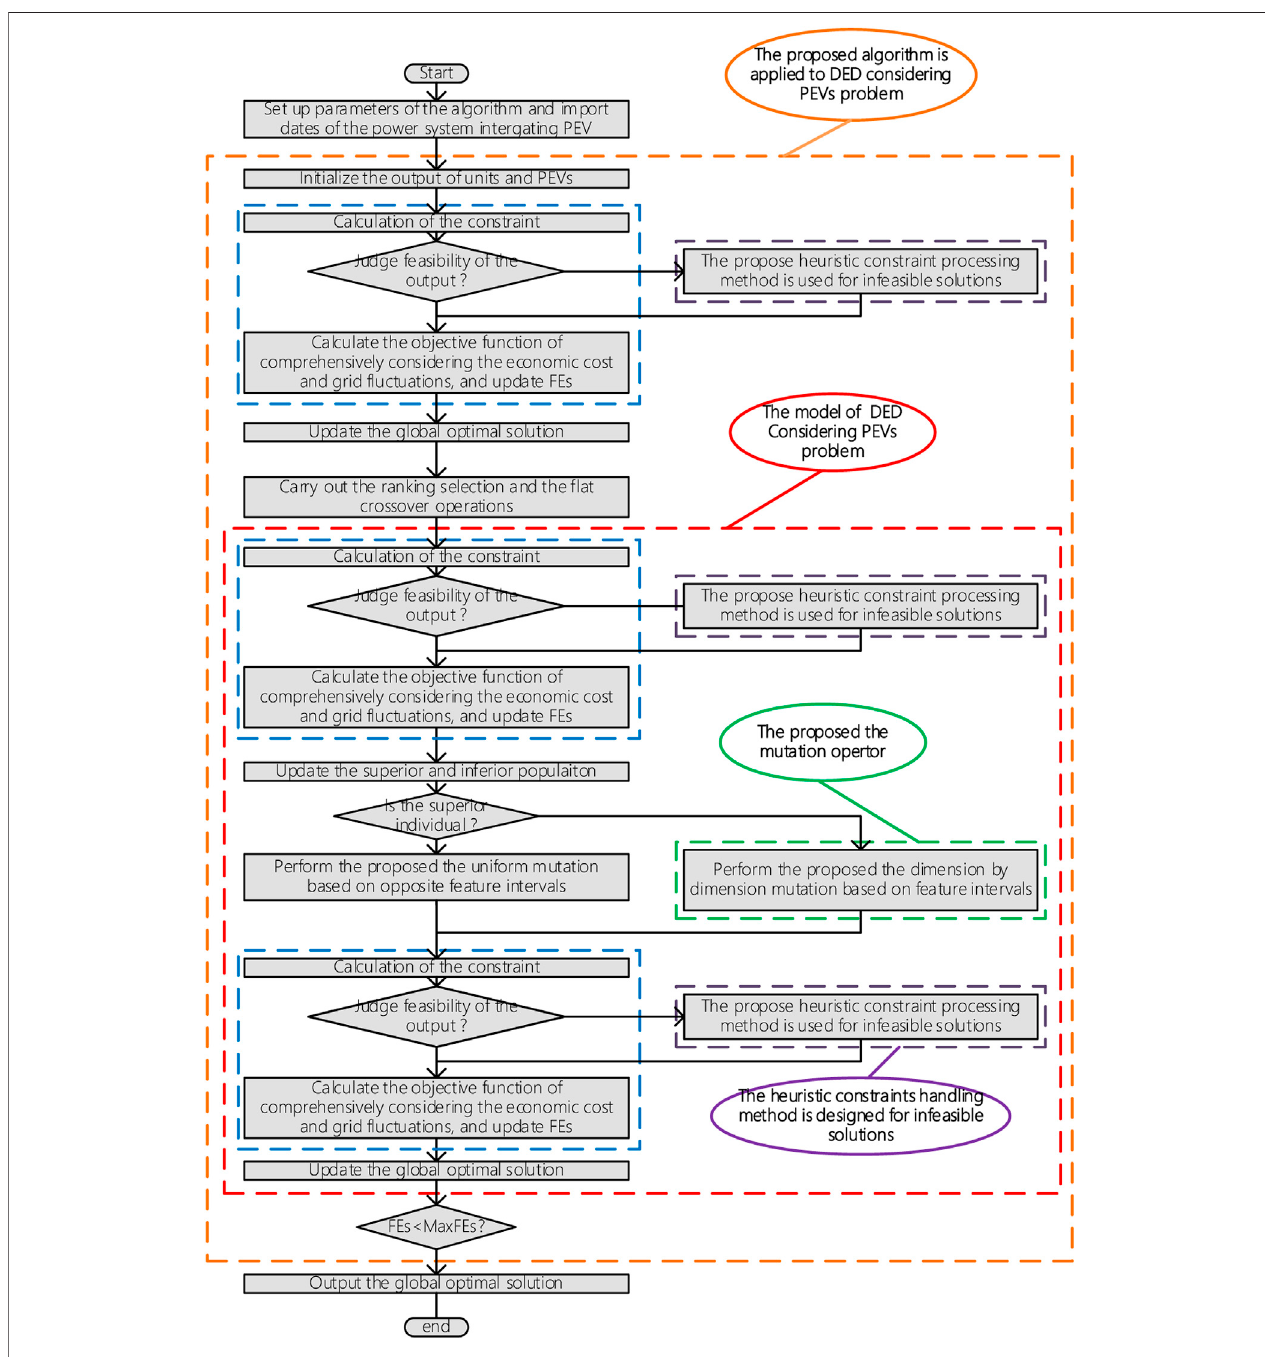
FIGURE 2 | The fl owchart of the implementation of GADMFI for the DED with PEVs.